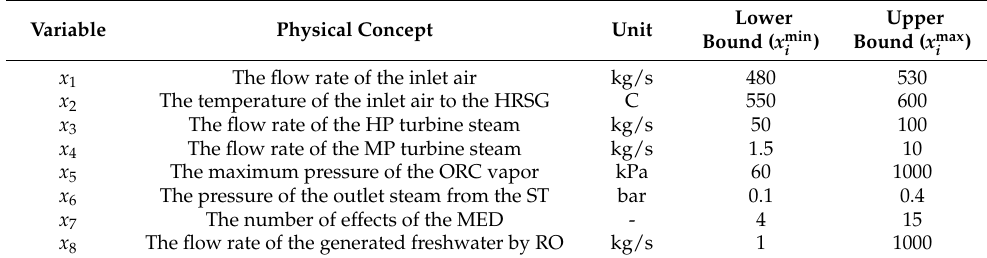
Table 3. Physical concept of the variables and their variations.